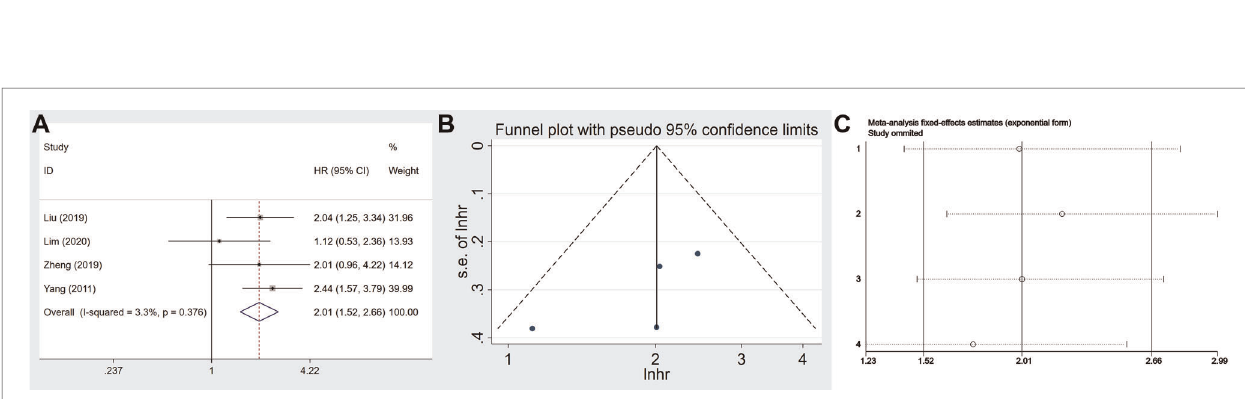
FIGURE 5 | The association of USP22 expression with the OS of GC patients: ( A ) forest plot, ( B ) funnel plots and ( C ) sensitivity